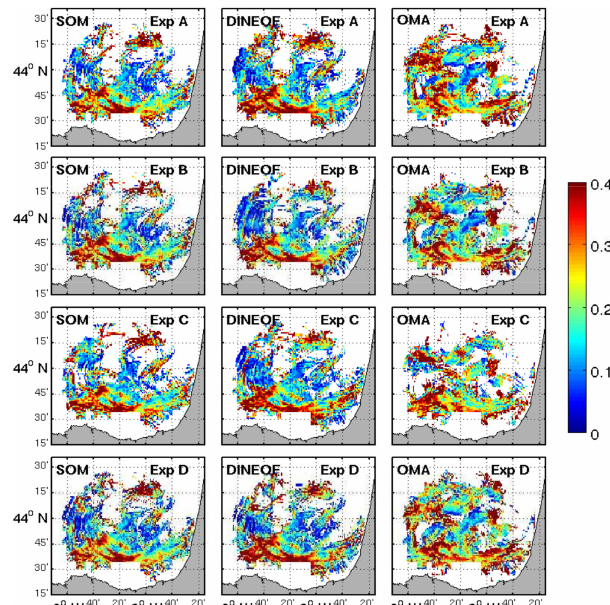
Figure 12. Maps of the time average of the pixel-by-pixel abso- lute relative error of the LCS computed from the three filled veloc- ity field with respect to LCS obtained from the reference currents. White denotes points at which LCSs have not been